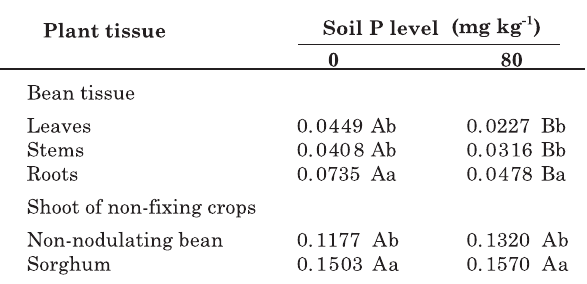
Table 2. Enrichment of 15 N (in atom % 15 N in excess) of different plant tissues; means of eight replications for bean tissues, and four replications for non-fixing crops, at two P levels applied to the soil (0 and 80 mg kg -1 )